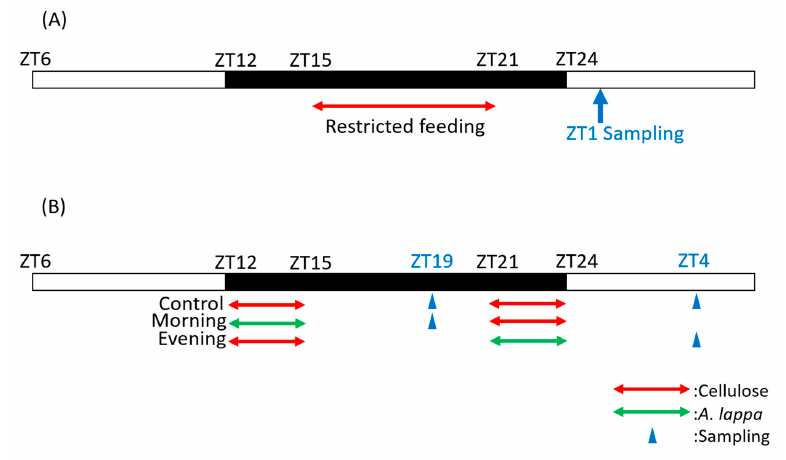
Figure 1. Experimental schedule. ( A ) Scheduling in experiment 1, and ( B ) scheduling in experiments 2 and 3. The white and black bars indicate environmental 12 h light and 12 h dark conditions. The red arrow indicates the feeding time with cellulose and green arrow indicates the feeding time with A. lappa . The blue arrow indicates the sampling time. In Experiment 1, mice were fed with each food from ZT15 to ZT21 and sacrificed at ZT1. In Experiments 2 and 3, the mice were fed with each food from ZT12 to ZT15 as morning intake and from ZT21 to ZT24 as evening intake and were sacrificed at ZT19 or ZT4.